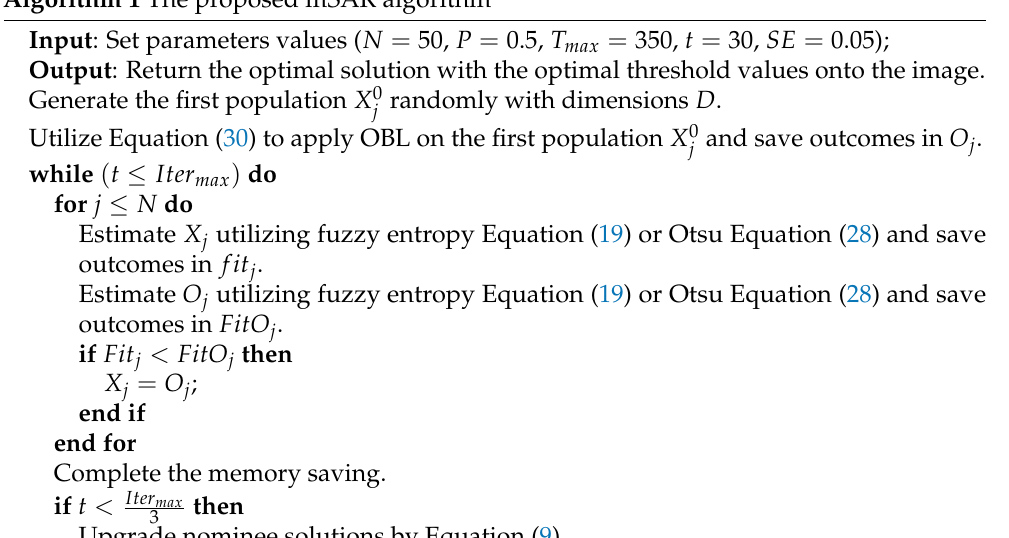
Algorithm 1 The proposed mSAR